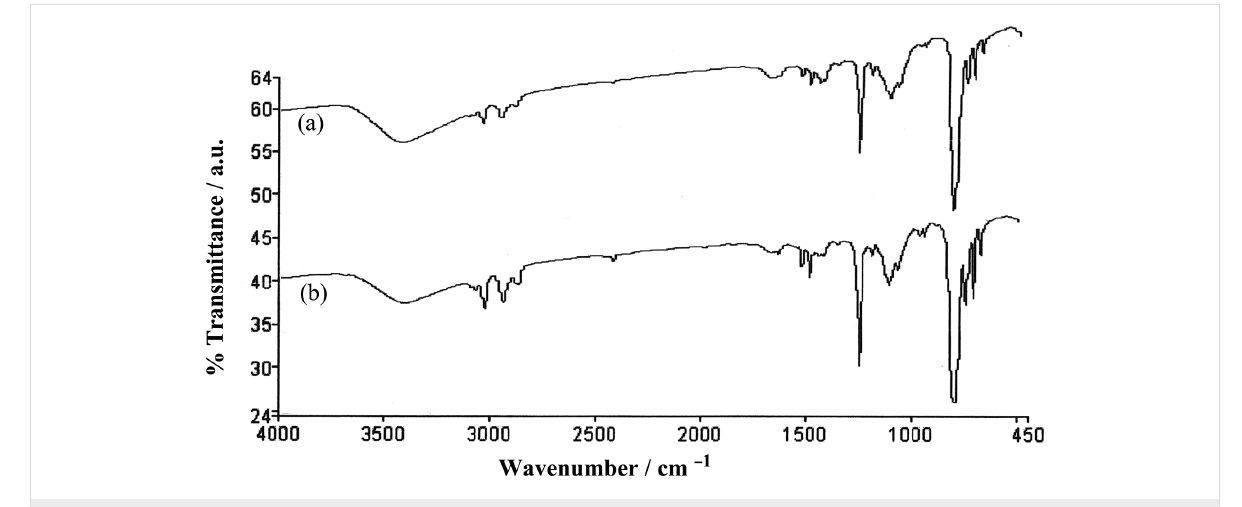
Figure 6: FTIR spectra of gelator TPM-G12 in (a) CHCl 3 and (b) xerogel in KBr.